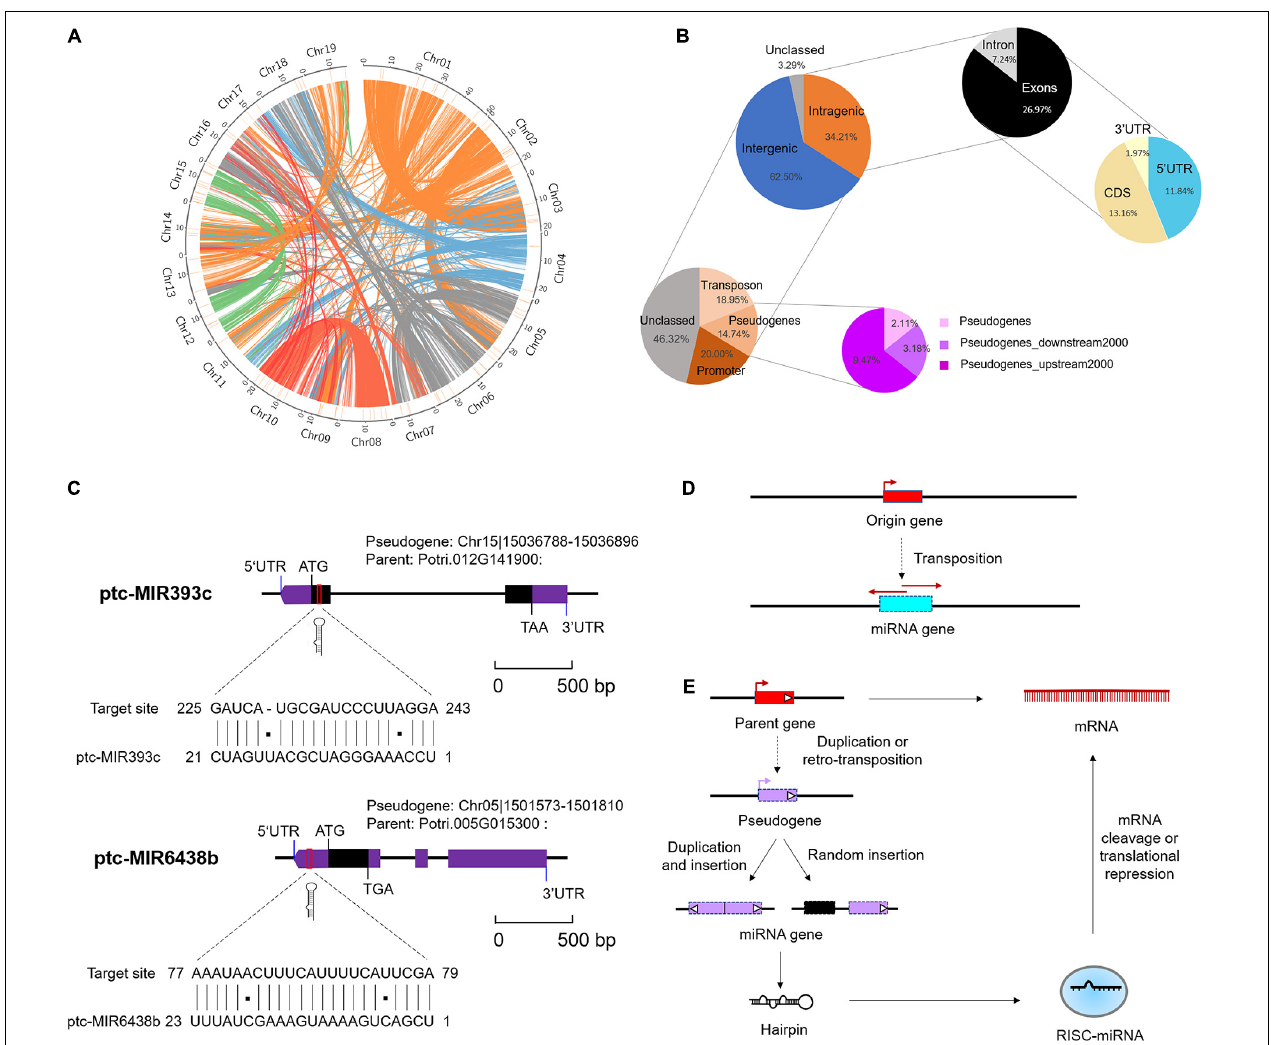
FIGURE 2 | Genomic locations of microRNAs (miRNAs) in Populus trichocarpa genome. (A) Genomic distribution of 152 Marssonina brunnea responsive miRNAs. Chromosomes are represented by the circle, and the inner circles (short orange lines) represent the location of miRNAs at the genome. The central colorful lines represent lines that connect syntenic block across chromosomes. (B) miRNA locations at the intergenic and protein-encoding genes (PEGs) region. The two charts on the top right indicate the locations of miRNA precursor sequences ( MIRs ) in the regions of PEGs. The two charts on the bottom left indicate the detailed classifications of MIRs overlapping with transposon, pseudogenes, and promoter region. (C) miRNA origin from pseudogenes and targeted parent gene. miR393c and miR6438b were selected as representative miRNAs. (D) Mechanism of miRNA gene origin from transposon. (E) Mechanism of miRNA gene origin from pseudogenes and feedback regulated the parent